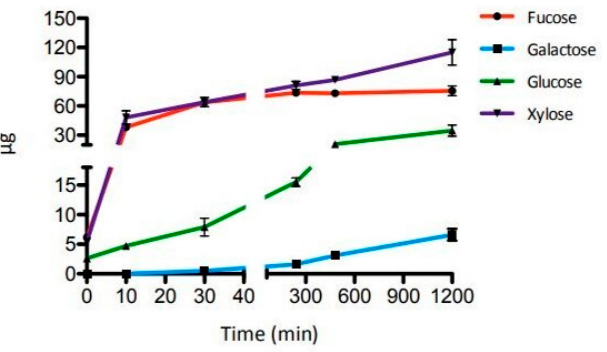
Figure 3. Time course of the enzymatic hydrolysis of XGO2. Error bars reported represent standard deviations.